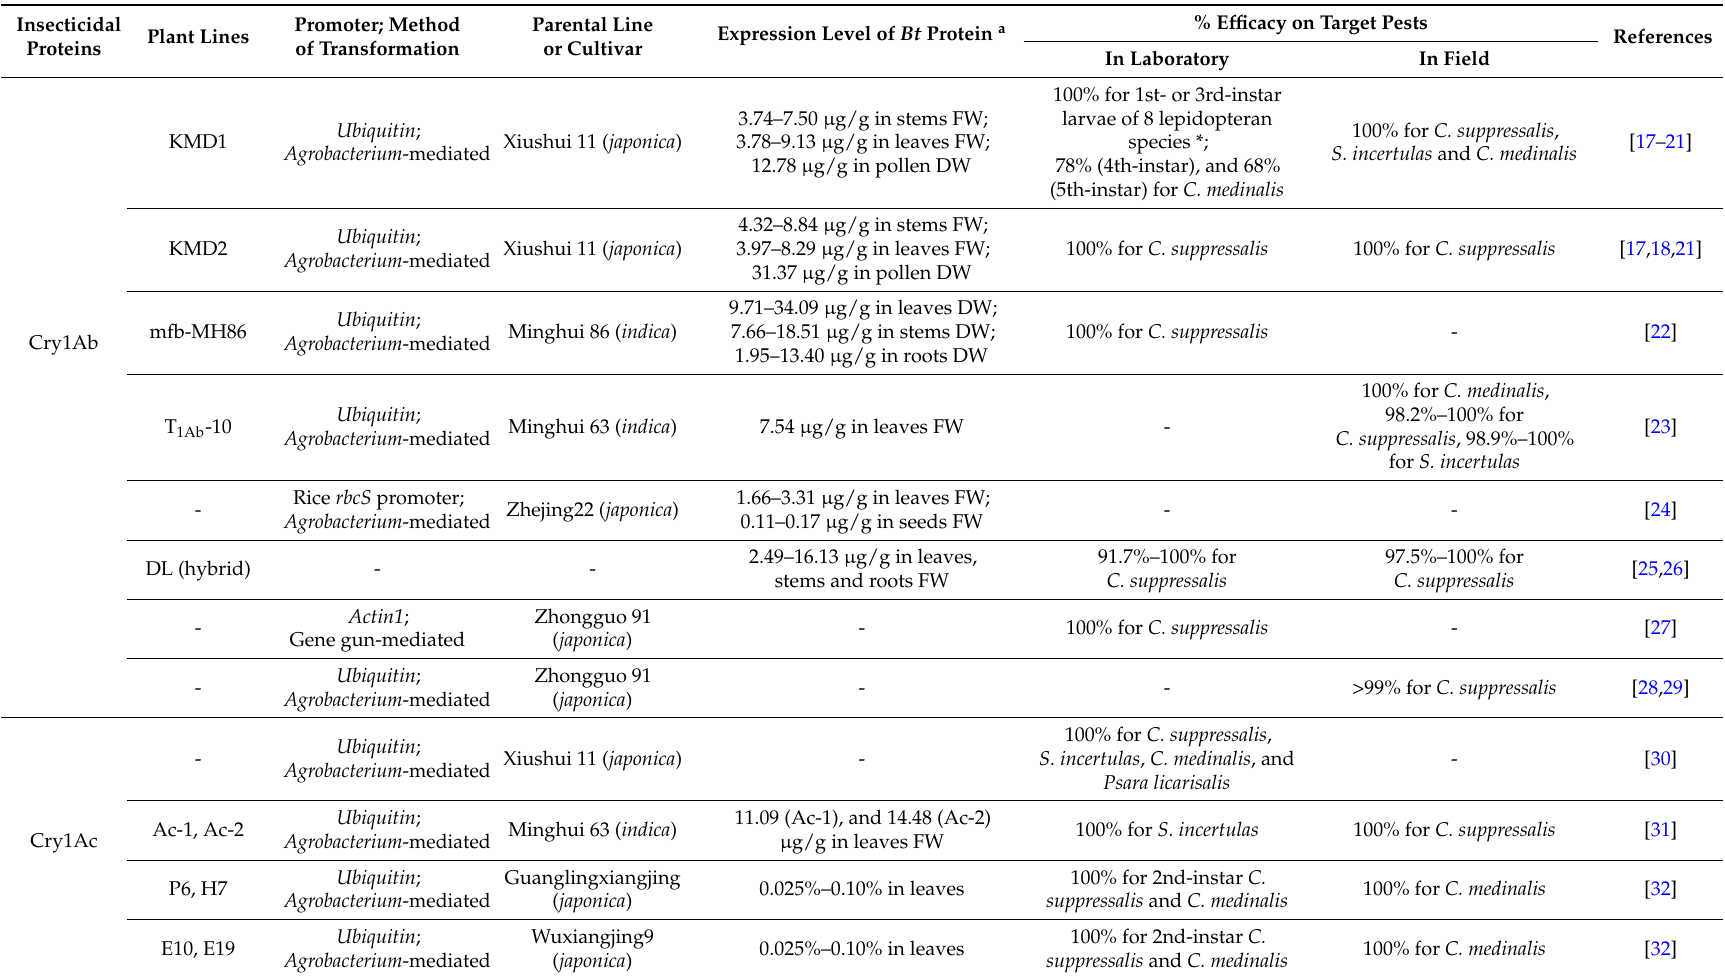
Table 1. Insect-resistant Bt rice lines and their efficacy on target lepidopteran pests in